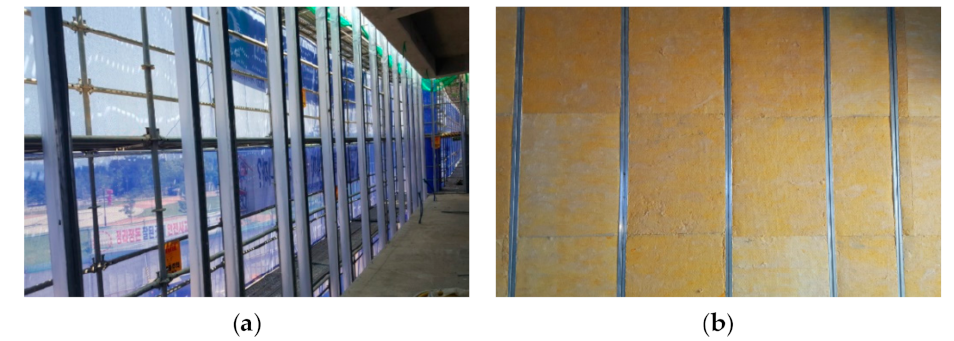
Figure 4. Installation example of the TIF and insulation: ( a ) installation of the TIF; ( b ) installation of insulation between the